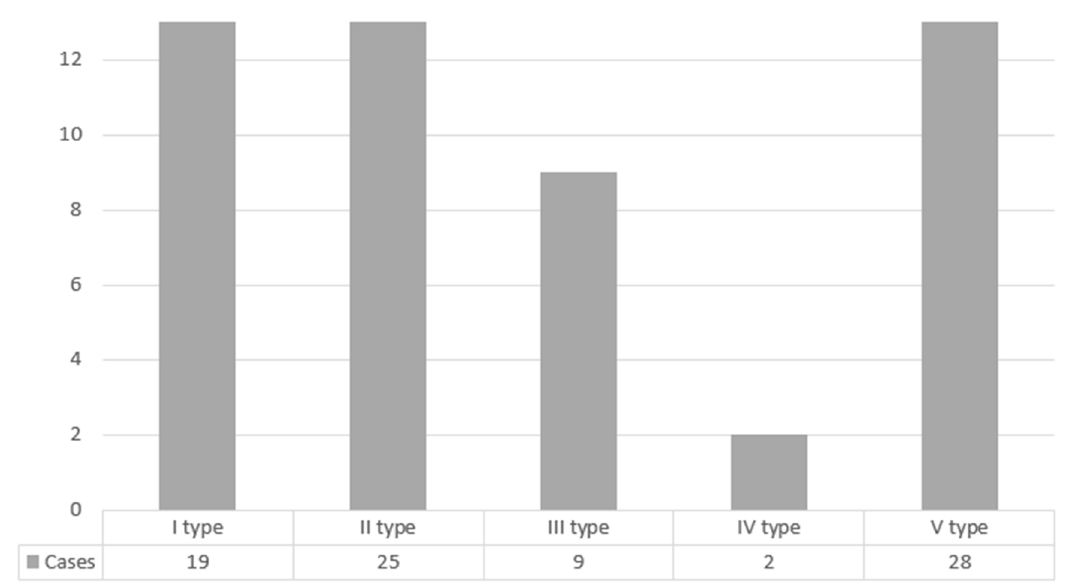
Figure 2 . Distribution of cases according to the anatomical relationship between the floor of maxillary sinus and causative teeth roots by Kwak classification.